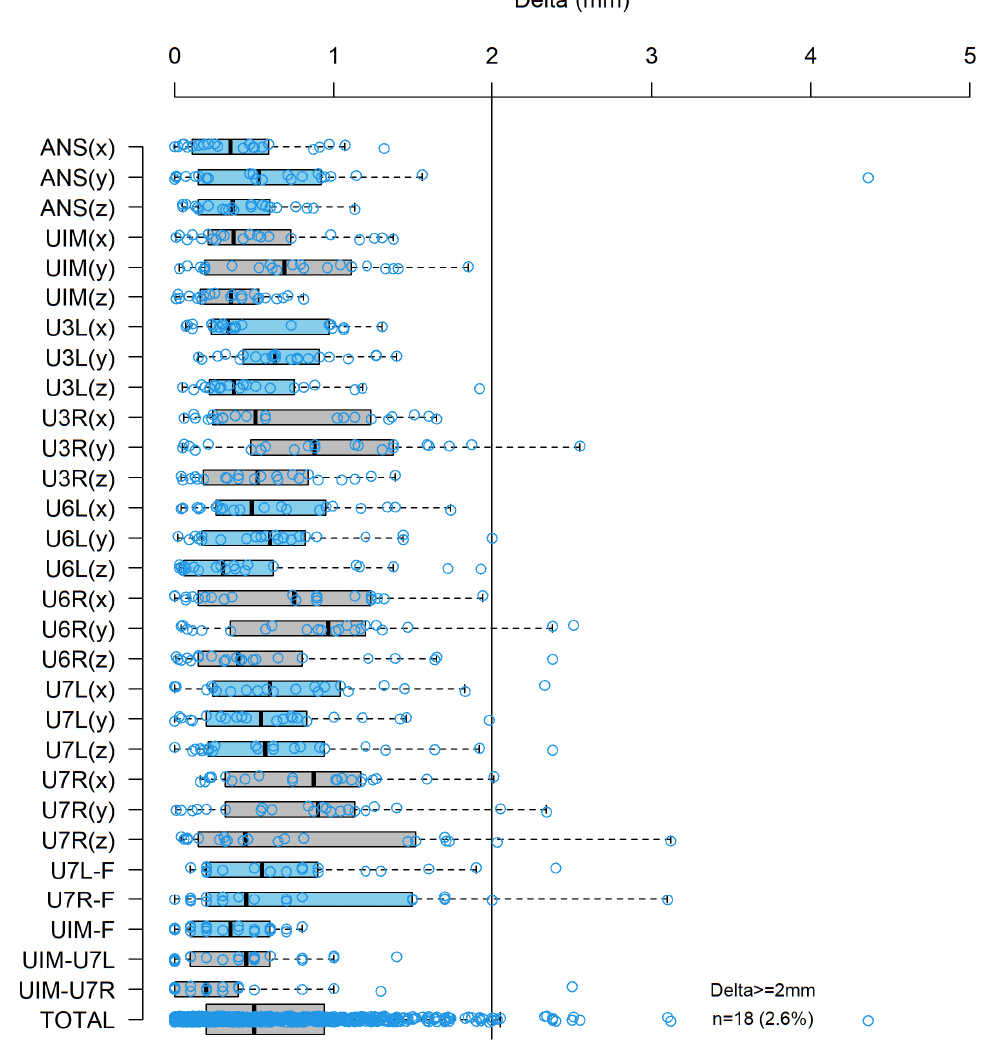
Figure 6. Boxplots presenting the absolute discrepancy between the postoperative position and the virtually planned postoperative position of the maxilla at each reference point.